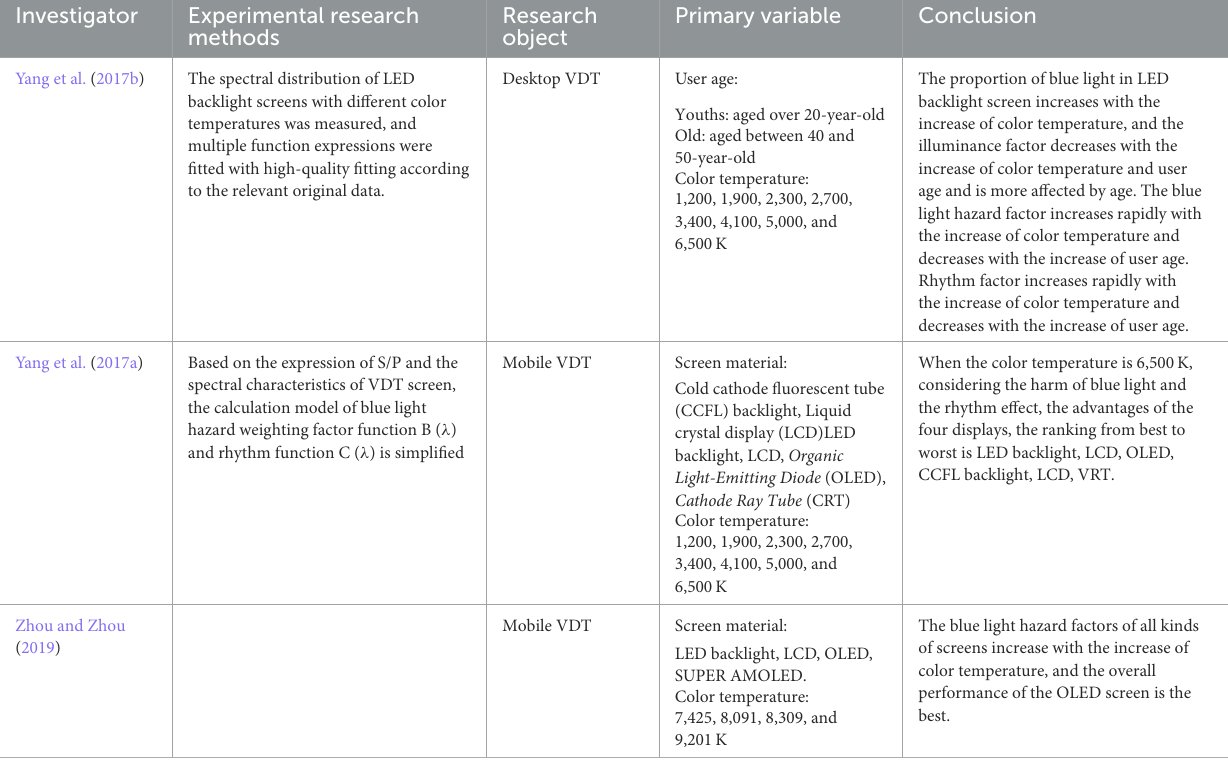
TABLE 5 Display the effect of color temperature on human health.